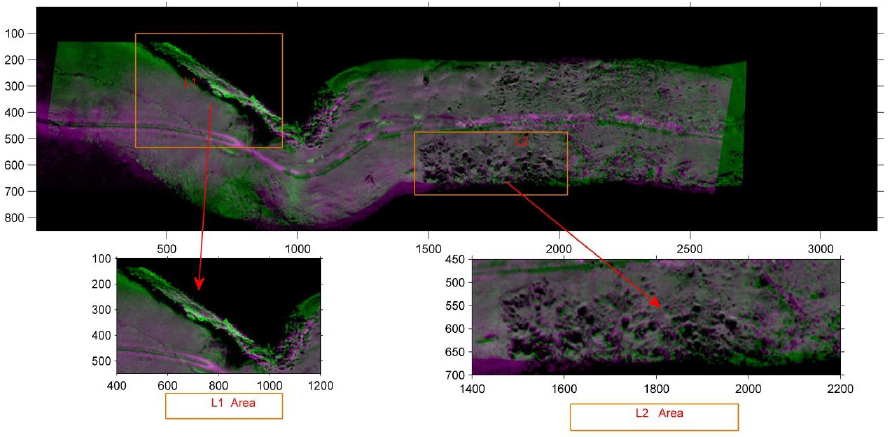
Figure 6. Overlapping image of underwater port. Purple is the left strip and green is the right strip.